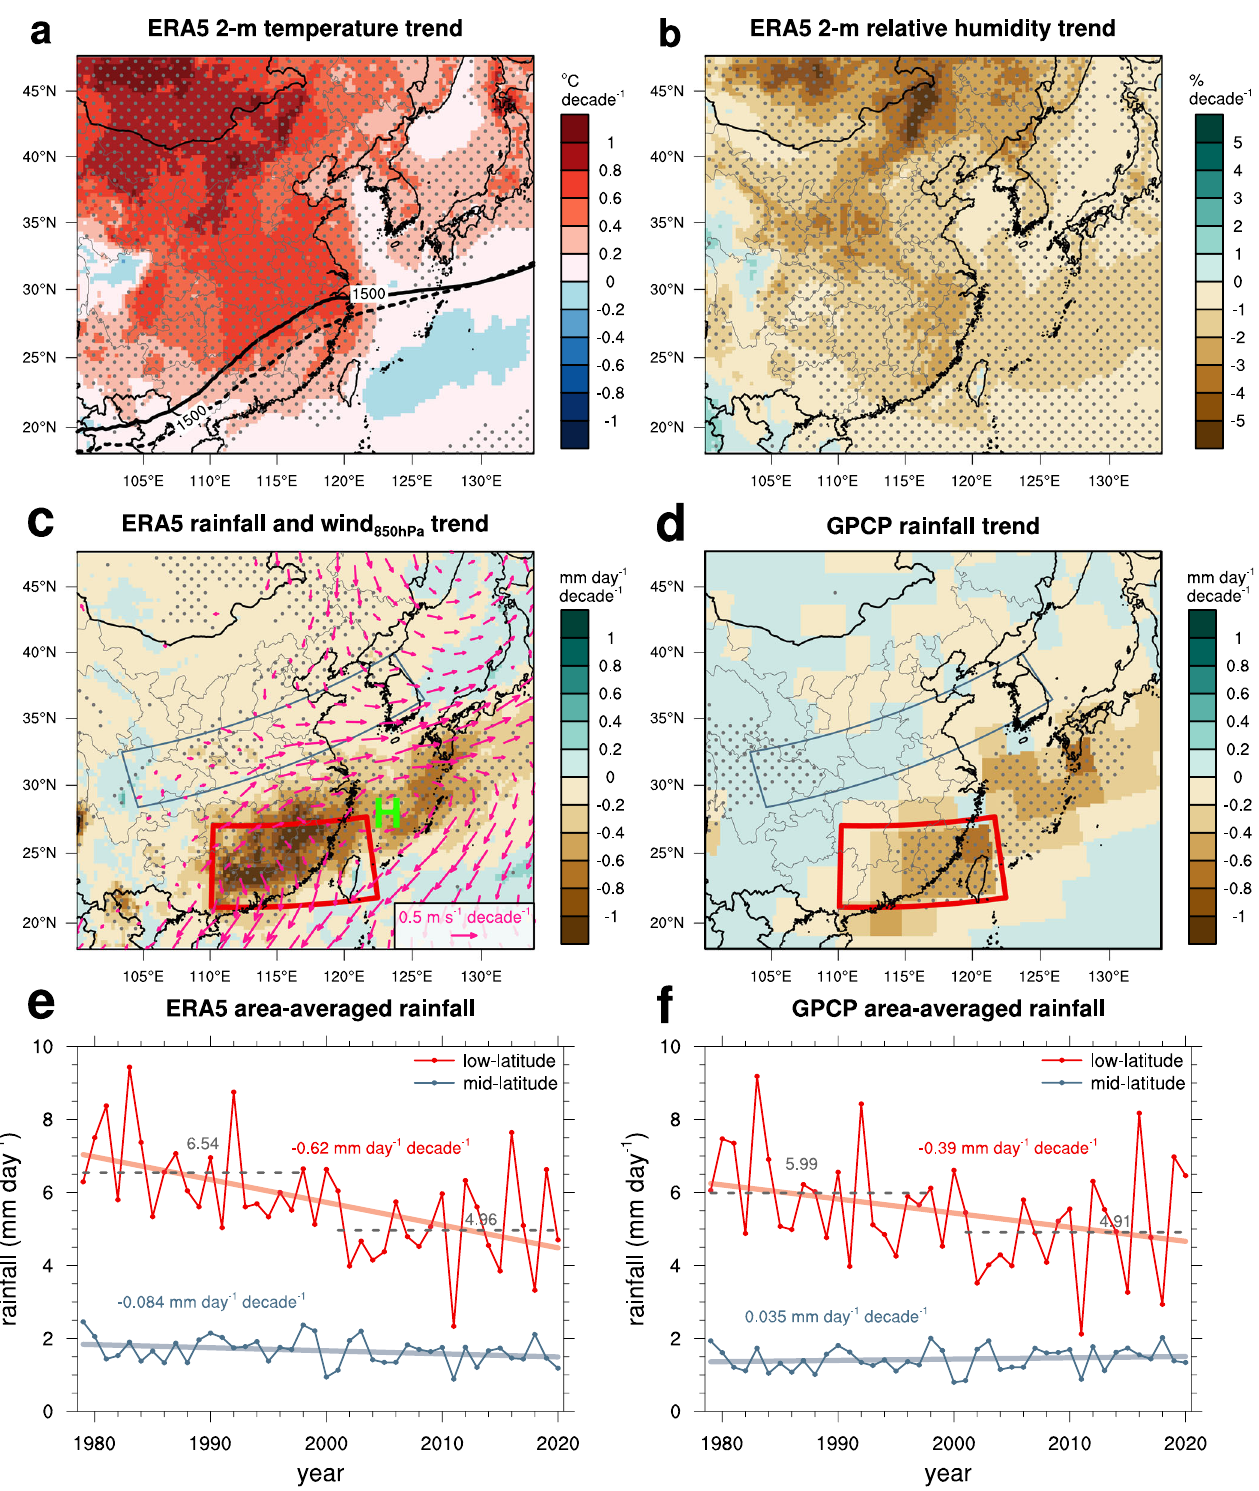
Fig. 1 Observed trends in temperature, RH, rainfall and wind. ERA5 trends in March – April mean ( a ) temperature at 2 m and ( b ) relative humidity (RH) at 2 m during 1979 – 2020. In a , the thick-solid and thick-dashed lines indicate the March – April mean geopotential height of 1500 m at 850 hPa during the latter 20-year period (2001 – 2020) and the former 20-year period (1979 – 1998), respectively. c ERA5 trends in March – April mean daily rainfall (shading) and 925 hPa winds during 1979 – 2020. Regions where elevation is >800 m are masked out in the 925 hPa wind trends. The red rectangle indicates the low-latitudes (southern China) (22° – 28°N, 110° – 123°E), and the blue rectangle indicates the mid-latitudes. d GPCP rainfall trend during 1979 – 2020. The stipples in ( a – d ) indicate that the trends are signi fi cant at the 90% con fi dence level ( p -value < 0.1). e Time series of March – April mean daily rainfall in the low-latitudes (red line with markers) and in the mid-latitudes (light blue with markers) and their linear trends (solid lines) from the ERA5 reanalysis data. f is the same as ( e ) but from the GPCP rainfall data. The numbers indicated above the gray-dashed lines in ( e ) and ( f ) are the 20-year mean daily rainfall for the 1979 – 1998 and 2001 – 2020